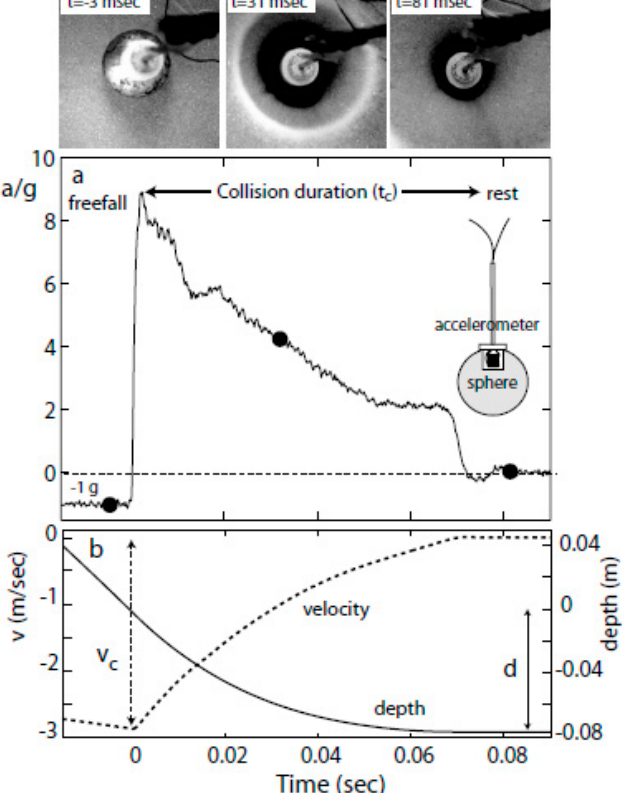
Figure 1. Three sequential images (overhead view) of an R = 1.91 cm steel sphere impacting glass beads at v c = 2.86 m/s with ( a ) the acceleration and ( b ) the velocity and penetration depth of the sphere during the collision [the three dots ( • ) in ( a ) correspond with the images]. The depth is defined as the distance from the lowest point on the sphere to the initial free surface of the grains. In addition, in ( a ) is a sketch of the instrumented projectile (not to scale) showing a single-axis accelerometer embedded in a sphere. (Reprinted with permission from Goldman and Umbanhowar ©2008 The American Physical Society).